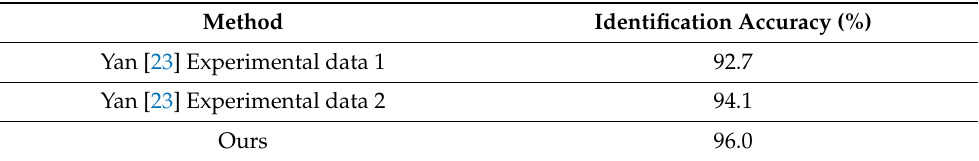
Table 3. Recognition accuracy comparison